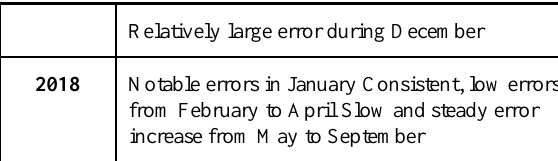
Table 4. Summary of the observed CT2 error patterns per year.